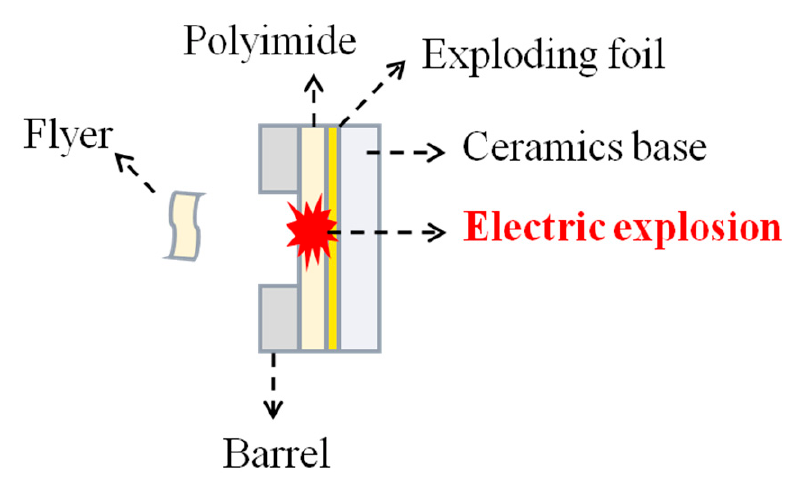
Figure 4. Diagrammatic sketch of the electrical explosion.